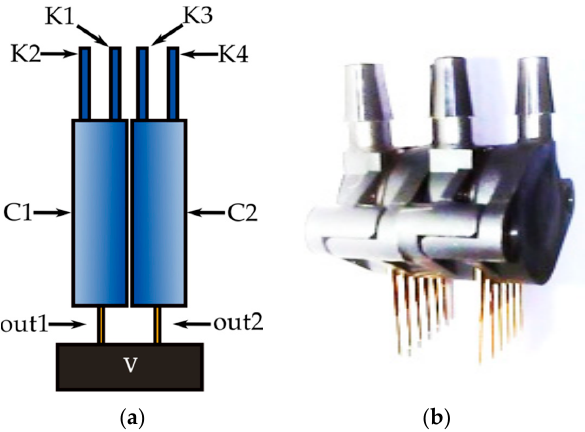
Figure 10. Scheme of installing and connecting the measuring and compensation sensors ( b ), C1— measuring sensor, C2—compensation sensor, K1 and K2—pressure input to the measuring sensor, K3, and K4-measuring inputs of the compensation sensor, out1—measuring sensor output, out2– compensation sensor output , ( b ) practical realization of scheme ( a )